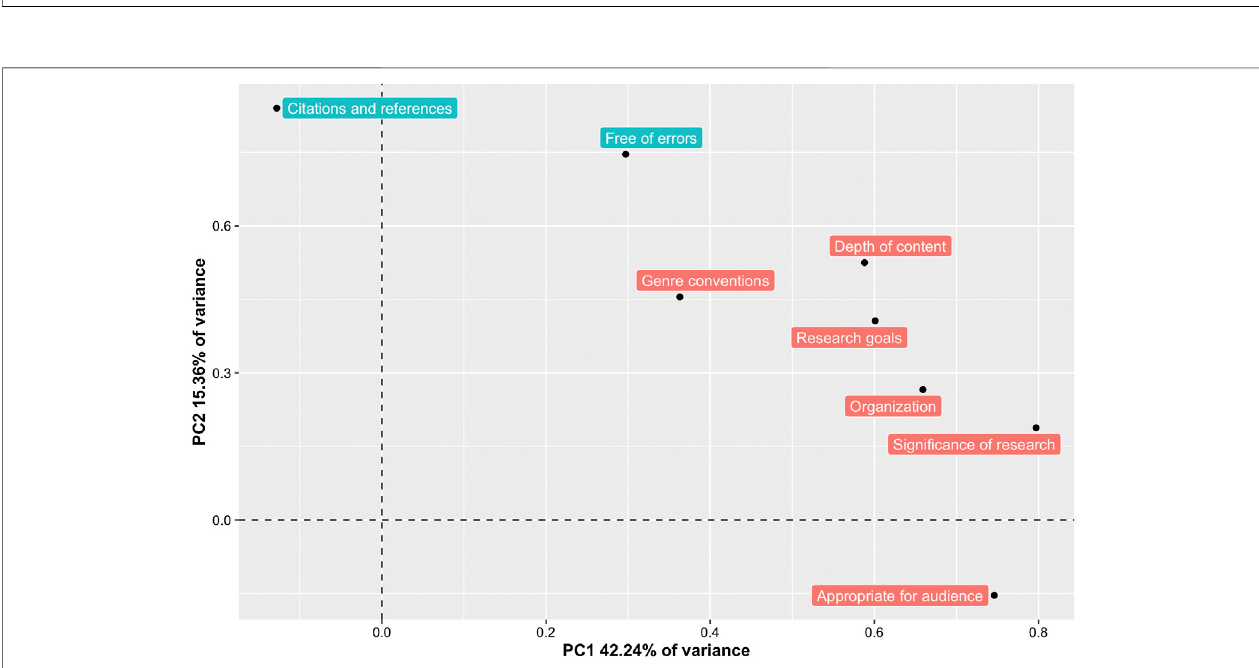
FIGURE 4 | Plot of principal component scores after Varimax rotation with Kaiser normalization for the eight rubric items used to evaluate thesis/dissertation proposalswrittenbySciWriteandnon-SciWritestudents.Rubricitemsthataddressedhigher-orderconcernsarelabeledinred,rubricitemsthataddressedlower-order concerns are labeled in